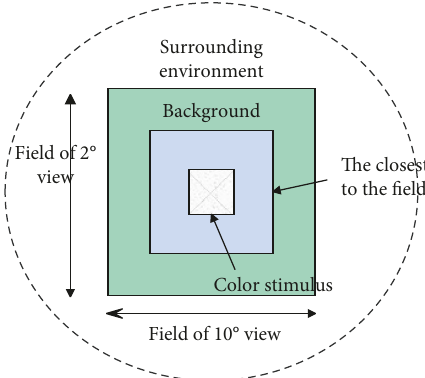
Figure 1: A typical observation